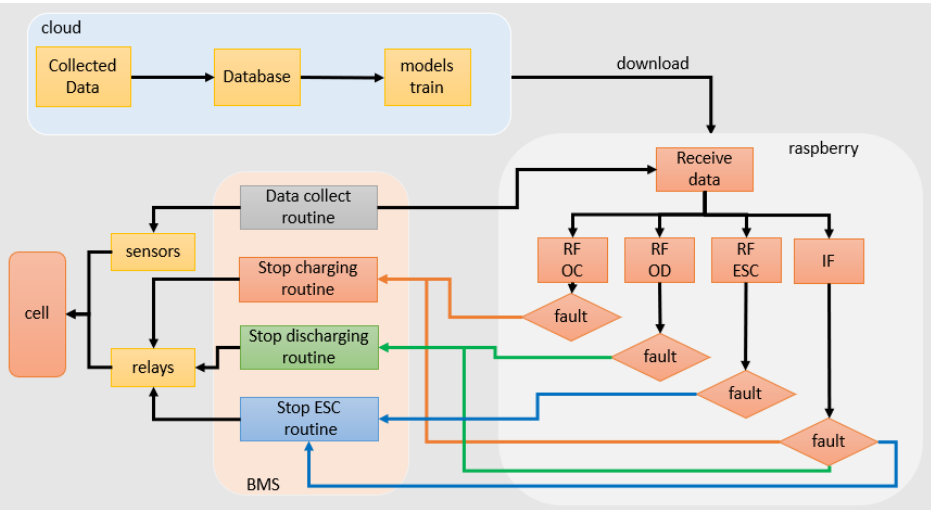
Figure 7. The logic operation of the ML models. The architecture is composed of the BMS, which measures the sensors and controls the discharging/charging cycles. The edge communicates with the BMS by the I2C protocol. The ML models are trained in the cloud to make inferences in real-time in the edge. The communication with the cloud is performed by WiFi for the